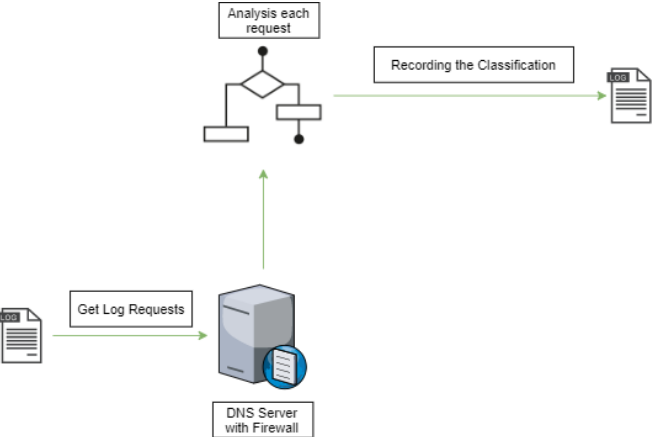
Figure 2. DNS Firewall operating Out-band.